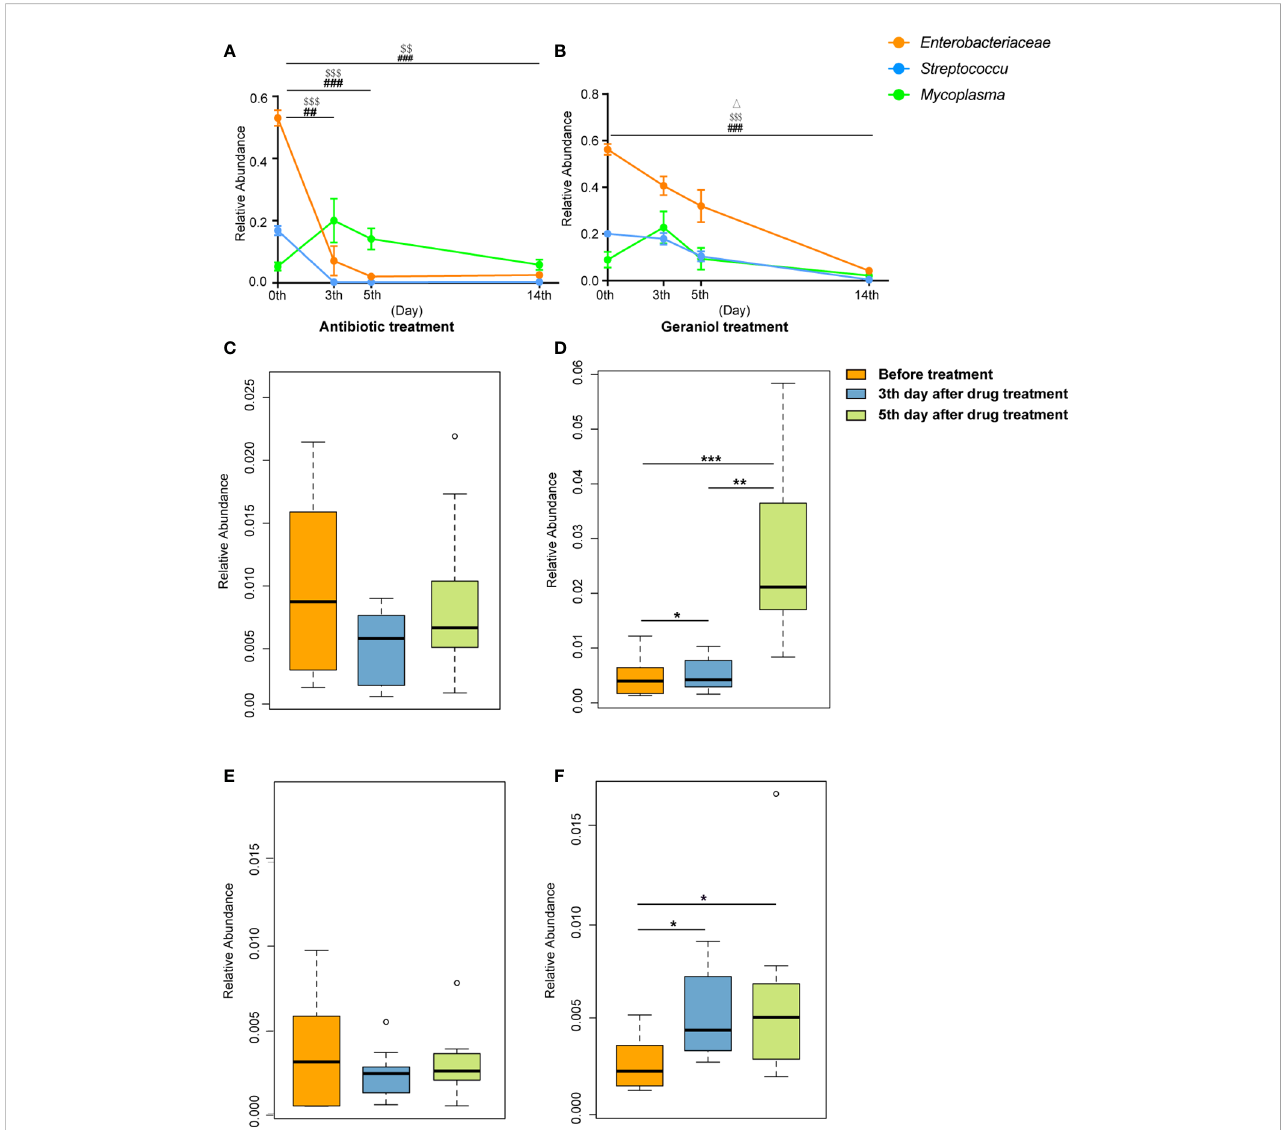
FIGURE 8 Dynamic changes of relative abundance of pathogens and probiotics in milk during the treatment of cow mastitis with antibiotics and geraniol. Dynamic changes of relative abundance of Enterobacteriaceae , Streptococcus and Mycoplasma in the milk of dairy cows with mastitis treated with antibiotic (A) and geraniol (B) ; Dynamic changes of relative abundance of Lactobacillus in the milk of dairy cows with mastitis treated with antibiotic (C) andgeraniol (D) Dynamic changes of relative abundance of Bi fi dobacterium in the milk of dairy cows with mastitis treated with antibiotic (E) and geraniol (F) . 3d and 5d means after continuous administration for three and fi ve days, separately; 14d means the 14th days after receiving drug treatment (It also means the 9th day after stopping drug treatment). [p values calculated by the One-way ANOVA test followed by post-hoc Dunn ’ s multiple comparisons test: ∗ < 0.05, ∗∗ < 0.01 and ∗∗∗ < 0.001); ## < 0.01 and ### < 0.001 for Enterobacteriaceae in (A) and (B) ; $$ <0.01and $$$ < 0.001 for Streptococcus in (A, B) , D < 0.05 for Mycoplasma in (B)